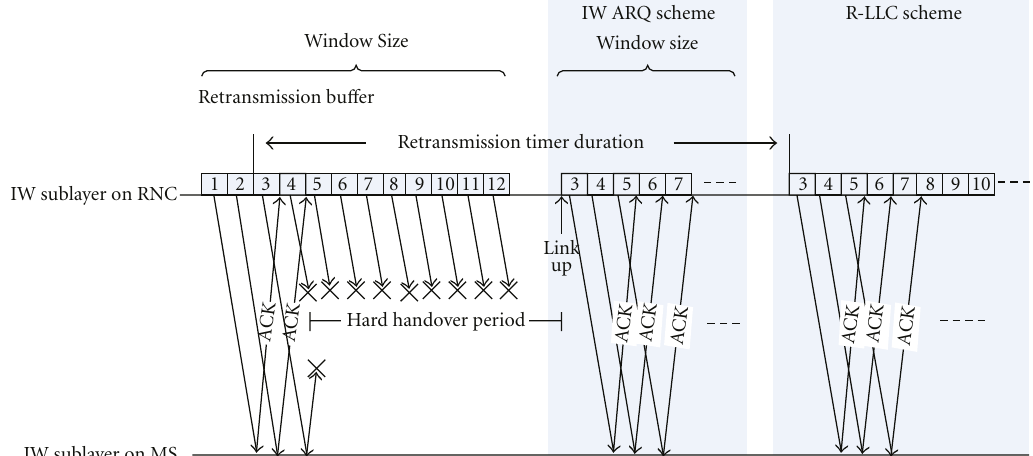
Figure 4: IW ARQ and R-LLC: an example of time evolution.